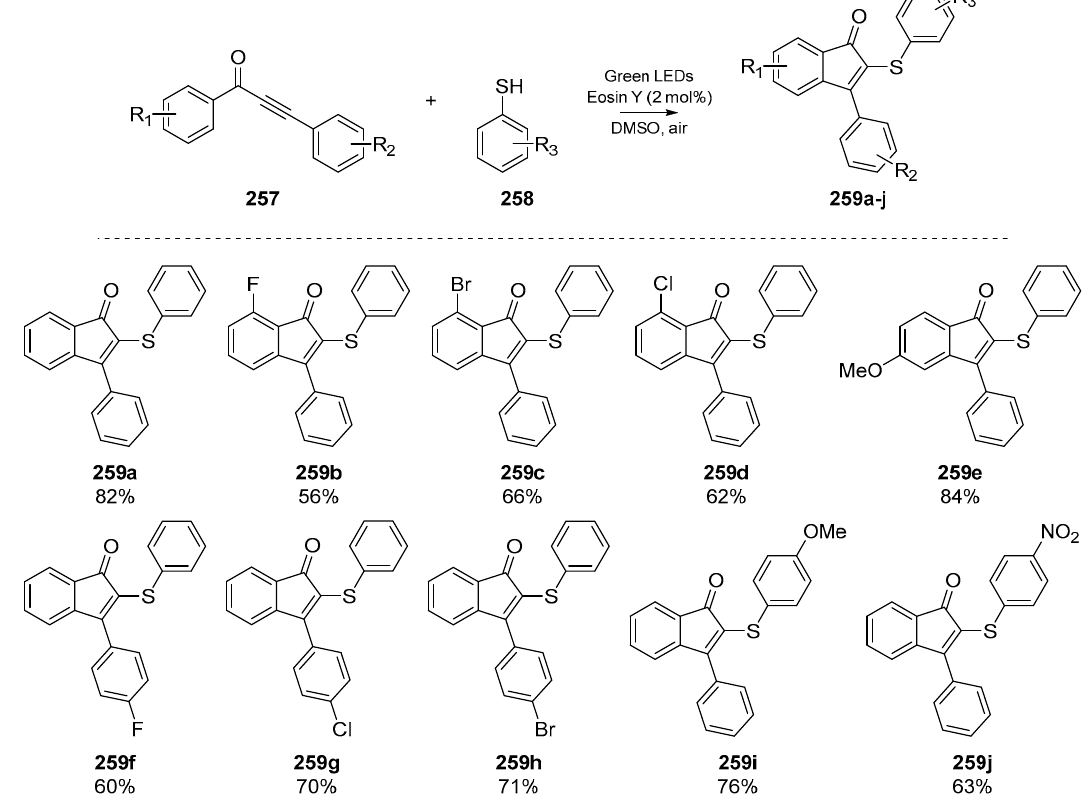
Scheme 40. Substrate scope examined by Chen and